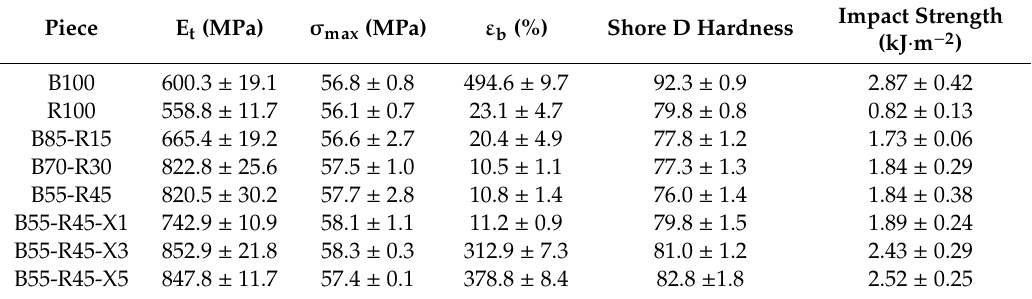
Table 2. Summary of the mechanical properties of the partially bio-based and recycled polyethylene terephthalate (bio-PET / r-PET) blends in terms of tensile modulus (E t ), maximum tensile strength ( σ max ), elongation at break ( ε b ), Shore D hardness, and impact